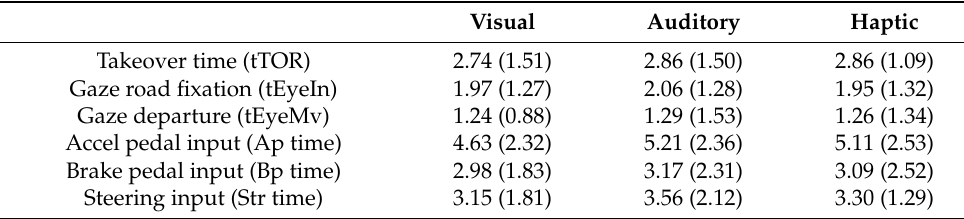
Table 2. Means and standard deviations of dependent variables.